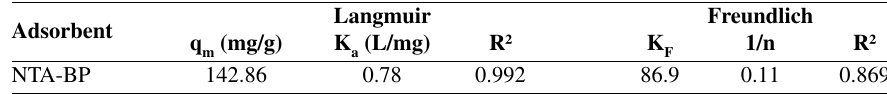
Table 2. Langmuir and Freundlich constants for the adsorption of MB on NTA-BP